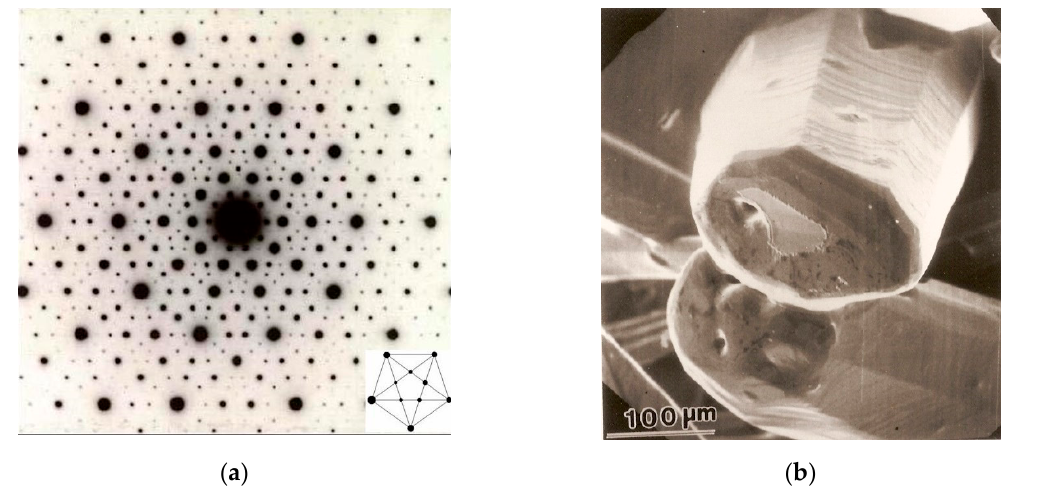
Figure 1. ( a ) Electron diffraction pattern of the d-Al ₇₀ Ni ₁₅ Co ₁₅ quasicrystal (QC) showing a ten-fold symmetry axis around the origin and a dense distribution of Bragg reflections. A set of consecutive nested pentagons, exhibiting the Pythagorean pentagram self-similar design, depicted at the bottom right corner, can be clearly seen; ( b ) scanning electron image showing the decagonal prism habit growth morphology corresponding to a d-AlNiCo QC. Cross sections of the decaprism show ten faceted planes where atoms are quasiperiodically arranged. These quasiperiodic planes are periodically stacked along the prism axis (Courtesy of An Pang Tsai).